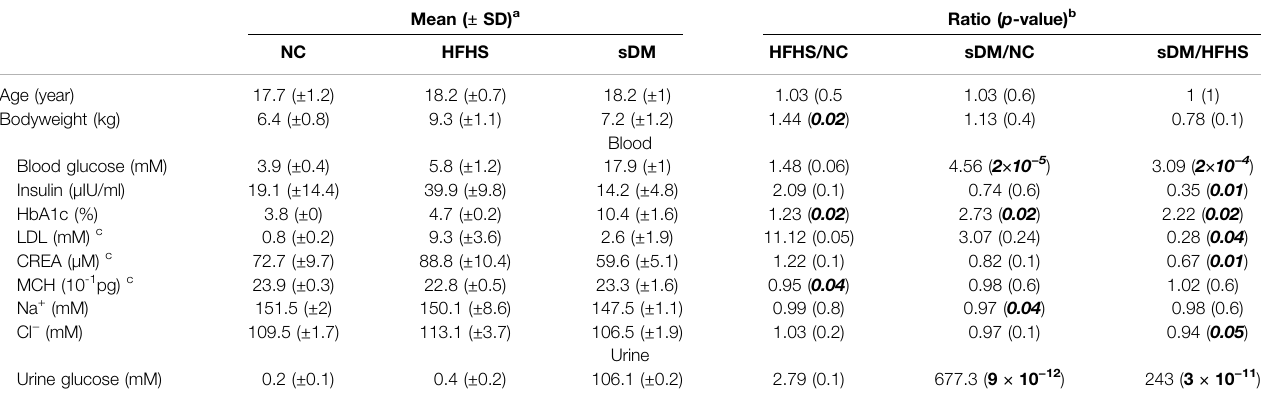
TABLE 1 | The clinical tests of all three groups of